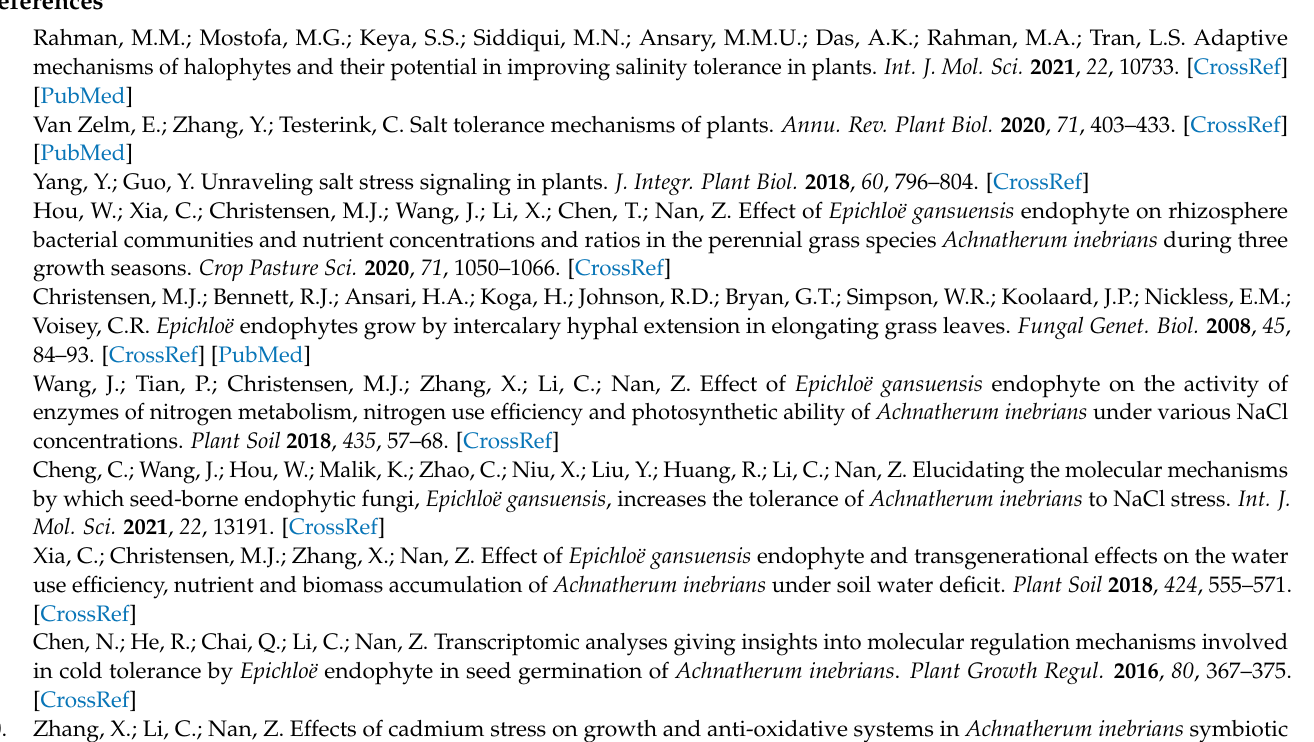
lation among samples, Figure S2: Volcano plots of differently expressed genes, Figure S3: Heatmap exhibits hierarchical clustering of differentially expressed genes, Figure S4: The principal component analysis (PCA) and orthogonal partial least squares discriminant analysis (OPLS-DA) for metabolic profiles, Figure S5: Histogram for the significantly different metabolites, Figure S6: Venn diagram analysis of differential metabolic pathways identified between 200 mM and 0 mM NaCl concentration in roots of E+ and E − plants; Table S1: Statistical table of Illumina sequencing output and alignment results between sample sequencing data and PacBio data, Table S2: Concentrations for significantly changed metabolites identified between E+ and E − plants under 0 and 200 mM NaCl